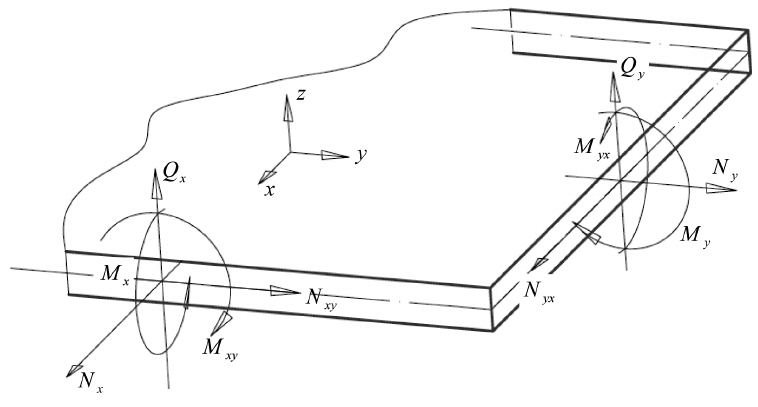
Fig. 3. Stress resultants on plate/shell